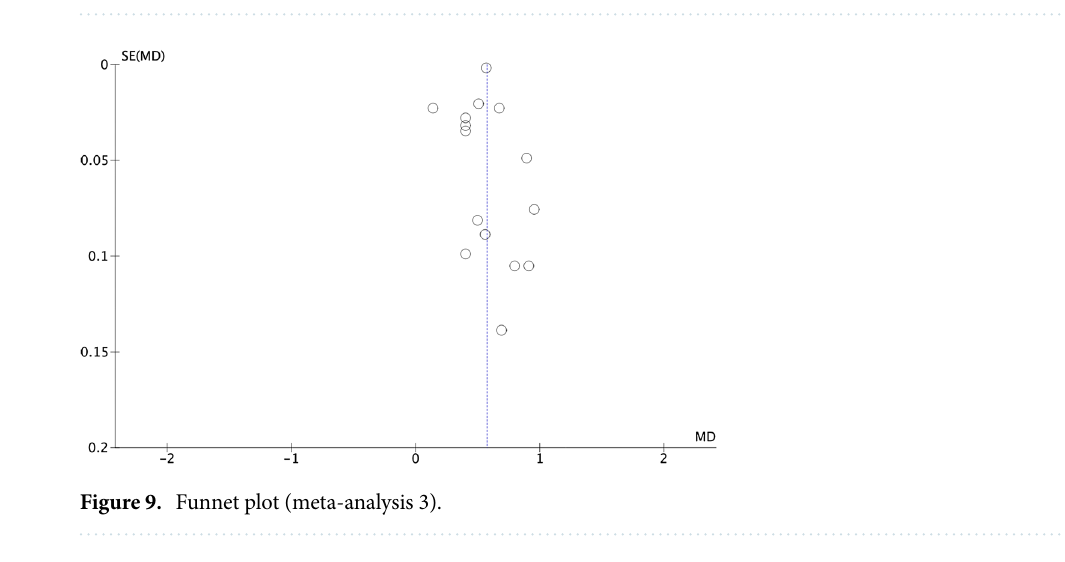
Figure 8. Results and summary statistics of studies analysing uric acid levels in women with and without metabolic syndrome (MetS) (meta-analysis 3).